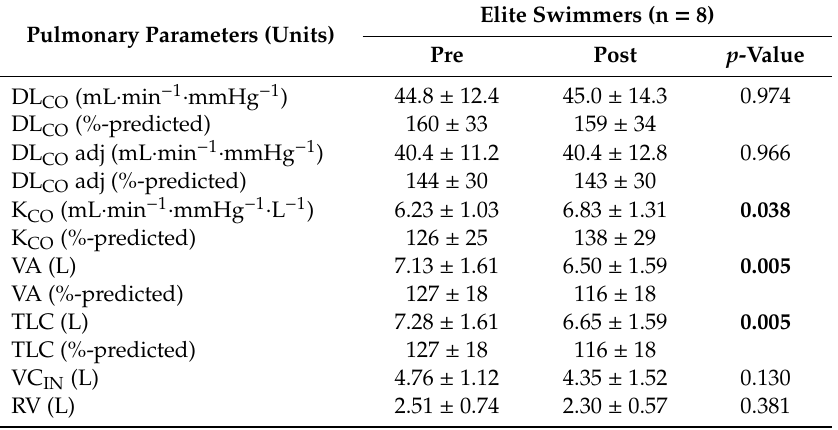
Table 2. Lung capacity and pulmonary gas di ff usion parameters before (day 3) and after (day 14) altitude training camp at 1850 m in elite swimmers.